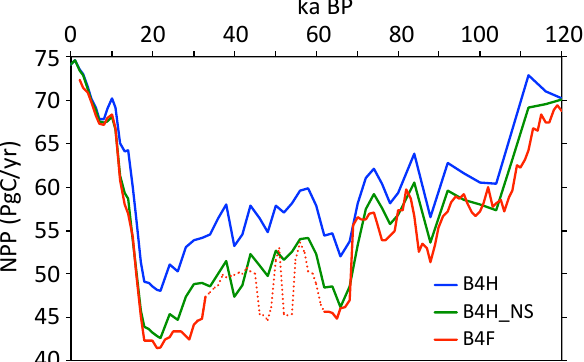
Figure 4. Net primary production throughout the last glacial cycle derived from the model-based biome reconstructions. B4H includes the additional influence of land exposed by sea-level changes, while B4H_NS and B4F do not. B4F NPP is represented by a dotted line between 30 and 60ka BP in the period where the Vostok CO 2 data used to force the FAMOUS simulation is thought to be erroneously